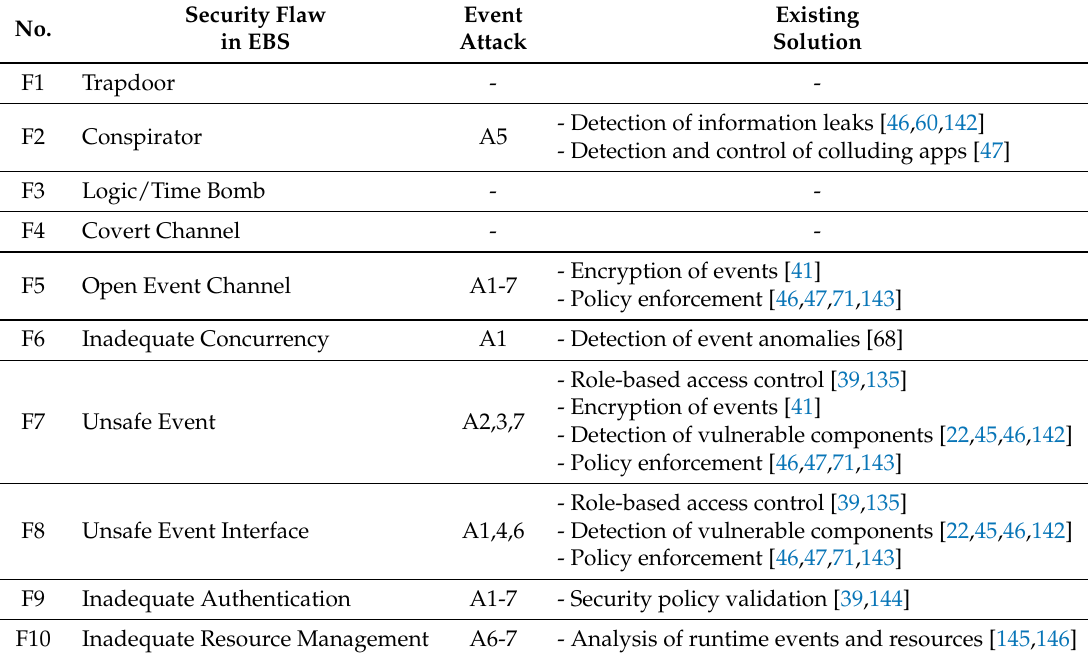
Table 3. EBS Security Flaws, Event Attacks, and Existing